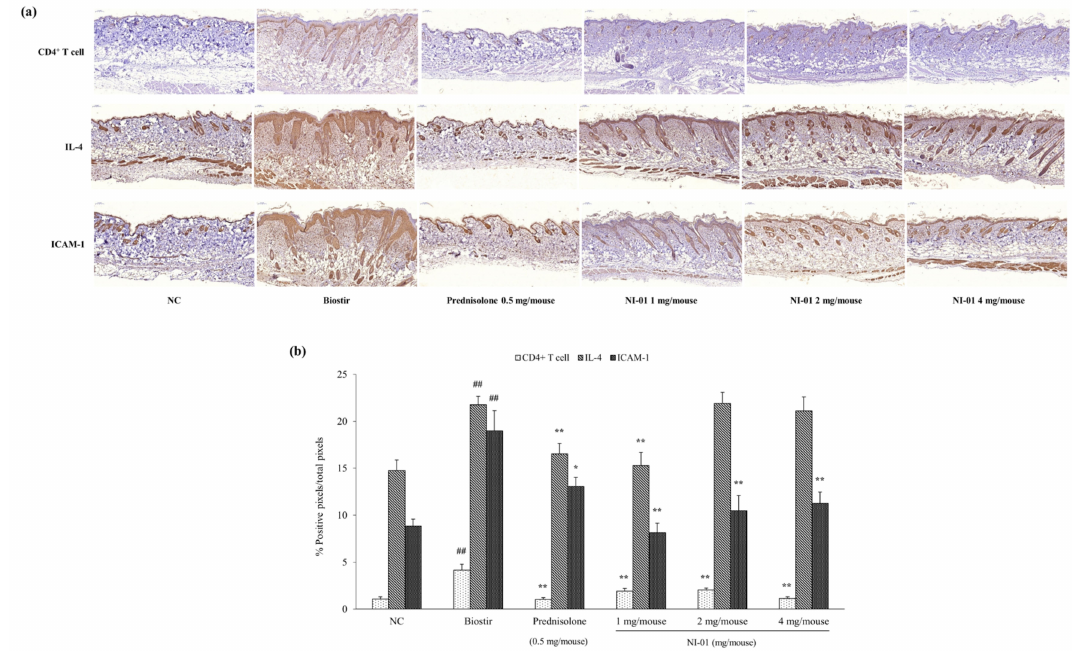
Figure 7. Immunohistochemical staining of dorsal skin lesions in house dust mite treated NC / Nga mice. Tissues were fixed with 4% paraformaldehyde, embedded in para ffi n and cut into thin sections. ( a ) Sections were immunostained with anti-CD4 + T cell, IL-4, and ICAM-1 antibodies. Prednisolone was used as a positive control. ( b ) The intensity represents the mean ± SEM ( n = 8). ## P < 0.01 compared with the normal control group; * P < 0.05 and ** P < 0.01 compared with the Biostir-AD ® group. NC; normal control, Biostir; Biostir-AD ® group.